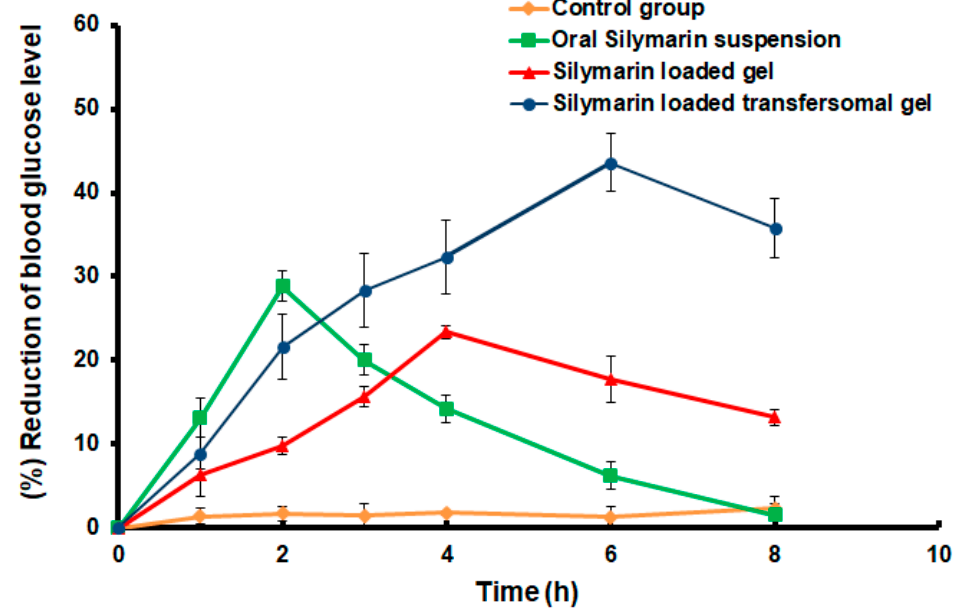
Figure 9. Percentage of blood glucose level reduction after administration of different Silymarin formulations. Data represented as mean ± SD ( n = 5).